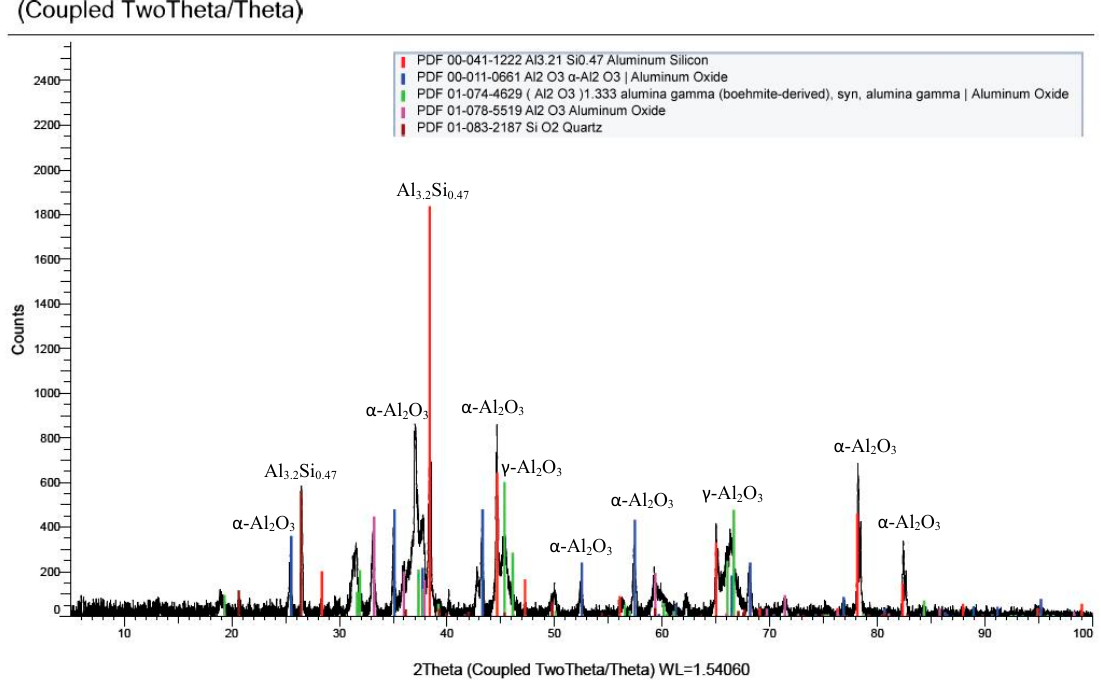
Figure 3. XRD of the dross left after ingot casting of incinerator bottom ash.